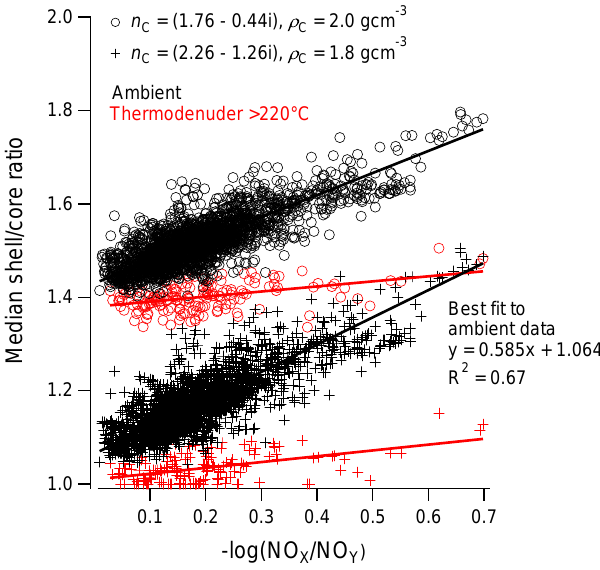
Figure 7. Sensitivity of variation in ambient median shell / core ratio to rBC core refractive index and density, listed in units of gcm − 3 . Data shown are the medians of each 5min period through- out the campaign, with error bars for the 25th and 75th percentiles.